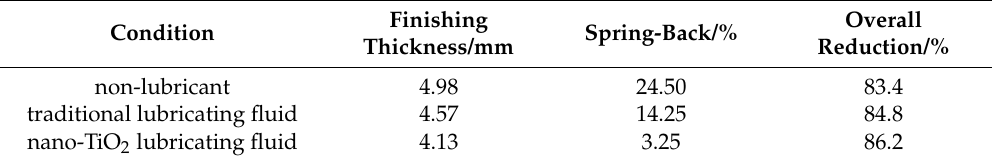
Table 5. The finishing thicknesses and spring-backs of the hot rolled steel